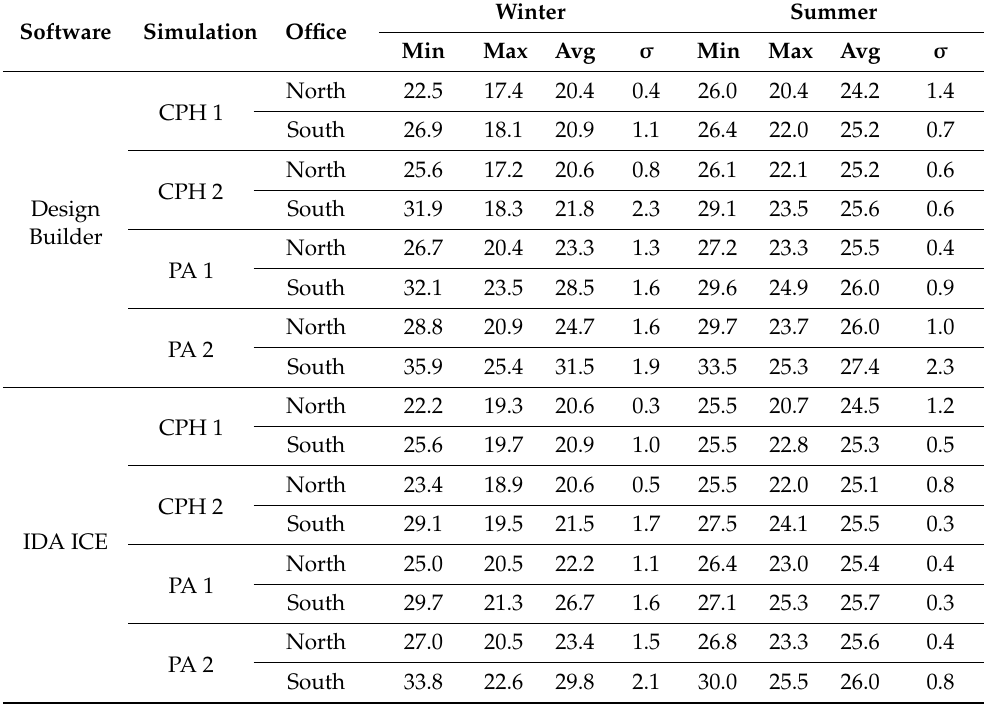
Table 4. Main statistic values of temperature data (in ◦ C) trends reported in Figures 2 and 3. Max: maximum operative temperature; Min: minimum operative temperature; Avg: average operative temperature; σ : standard